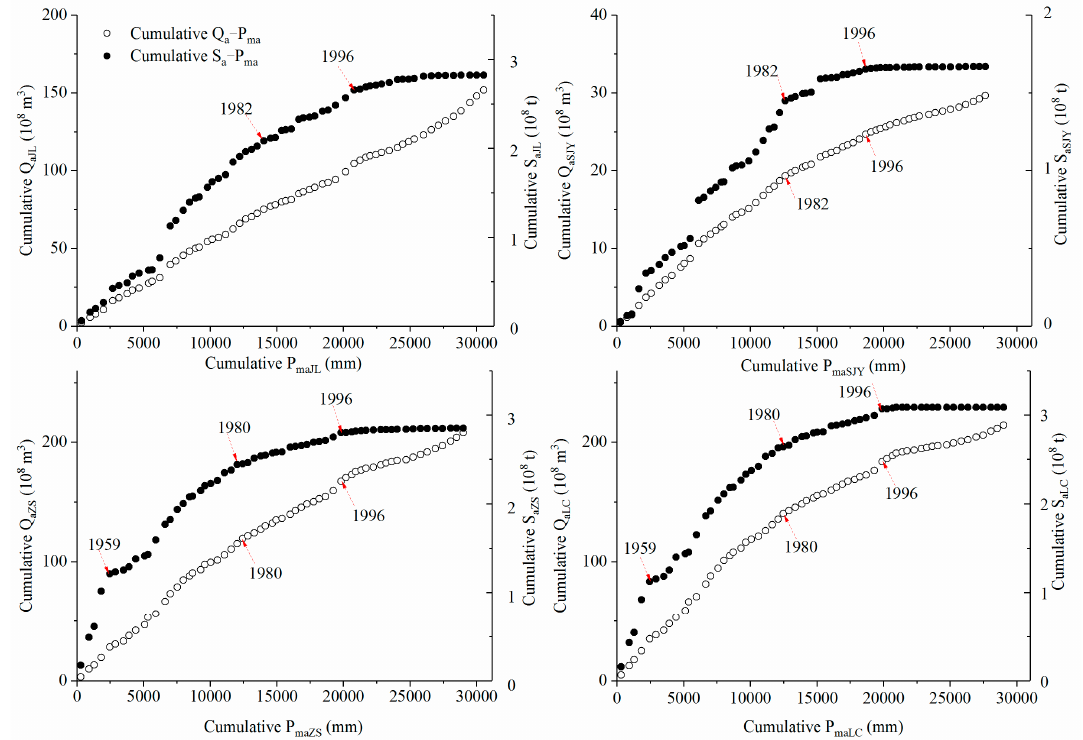
Figure 4. Double-mass curves of Q a − P ma and S a − P ma for four hydrological stations from 1955 to 2015. Dotted red arrows denote inflection point years during the study period using double mass curves.